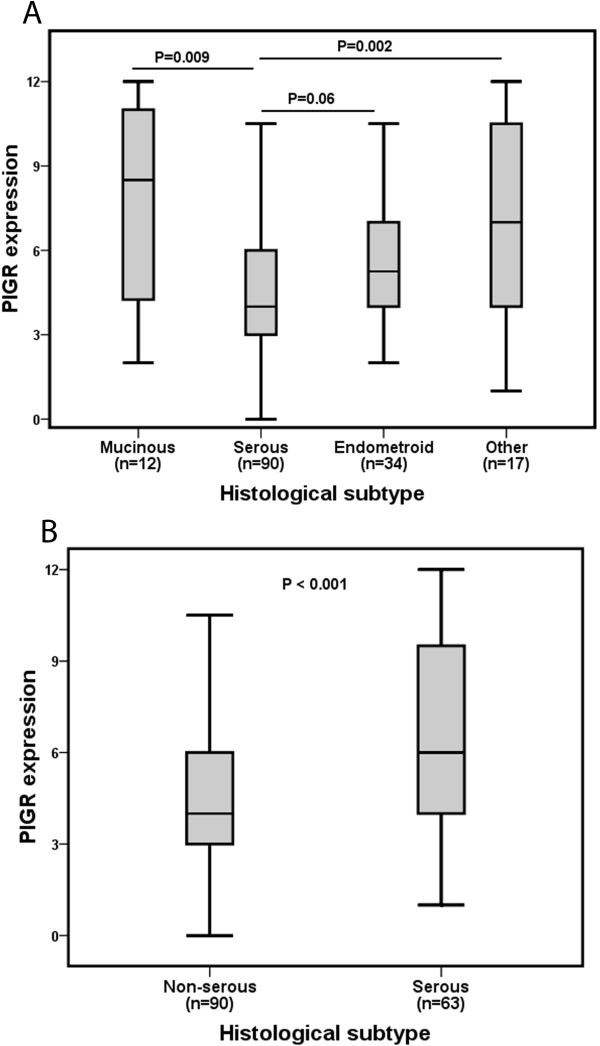
Distribution of PIGR expression in histological subtypes. Box plots visualising (A) the staining distribution of PIGR in different histological subtypes and (B) in serous vs non-serous carcinomas. PIGR expression is described as cytoplasmic score, i.e. a multiplier of fraction (0-4) and intensity (0-3) of staining.